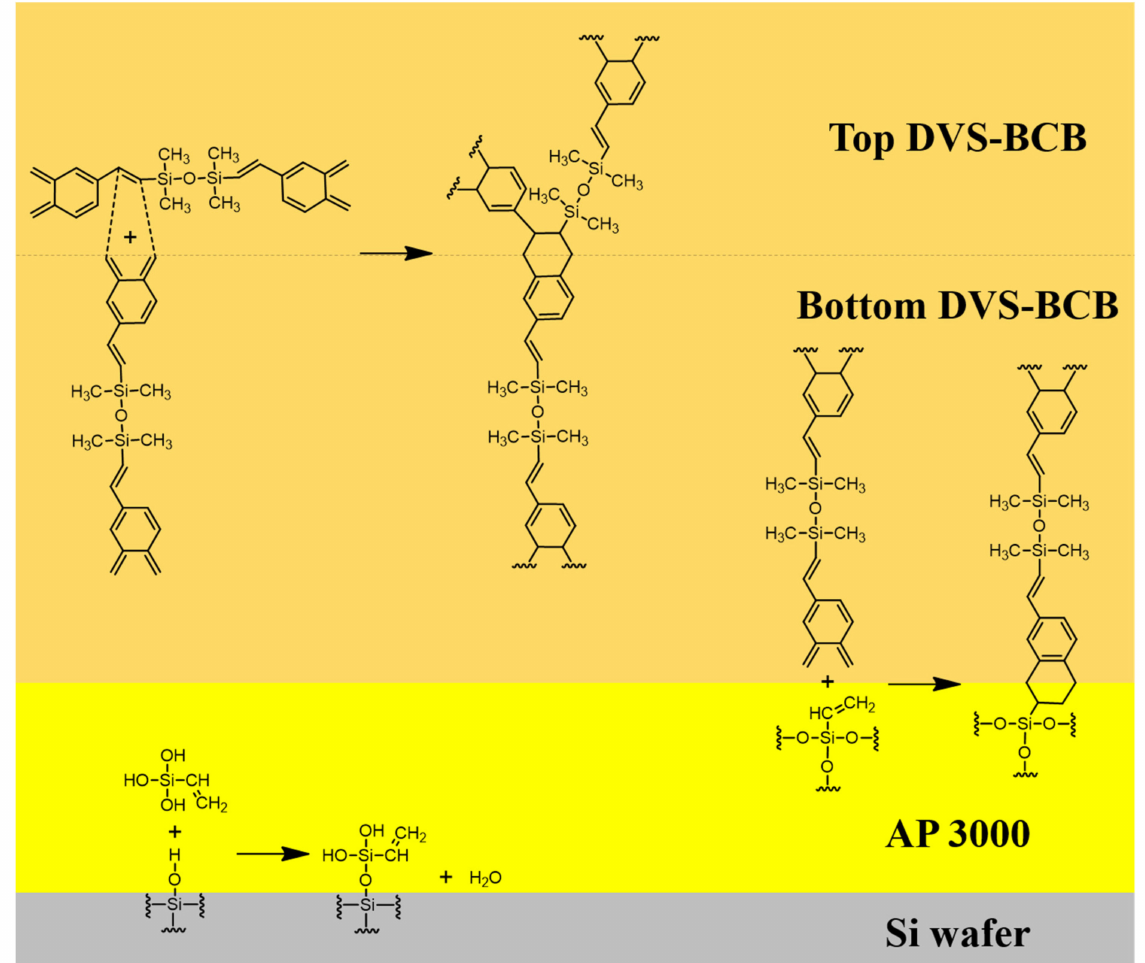
Figure 3. Reaction mechanism of the reaction occurring on the surface of each material during the curing